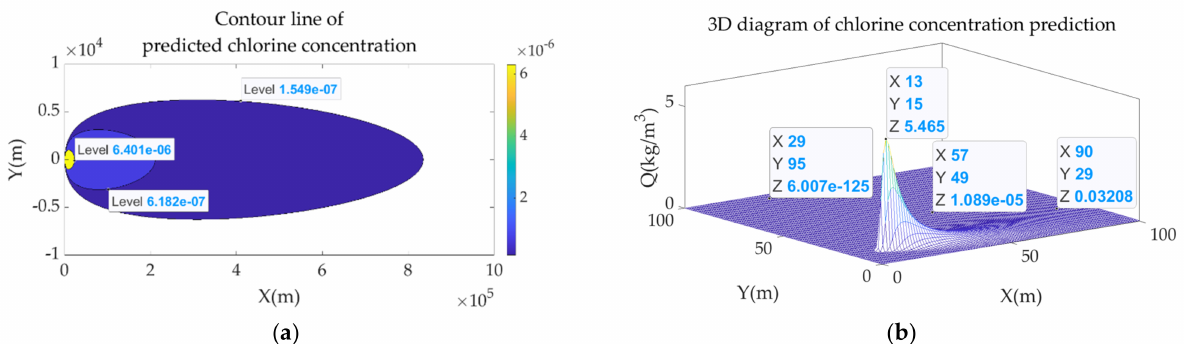
Figure 7. Supplement to chemical gas leakage accident system. ( a ) Prediction of gas concentration distribution and contour division under the AEGLs standard; ( b ) 3D diagram of prediction of gas concentration distribution.